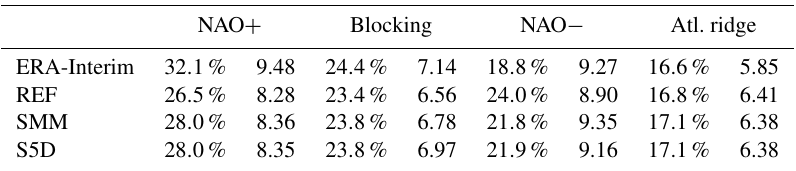
Table 3. Correlation between ensemble mean DJF North Atlantic– Europe weather regime frequencies in experiments REF, SMM, and S5D and ERA-Interim. Weather regimes are defined for a duration of 3 days or more. NAO + Blocking NAO − Atl. ridge REF 0 . 21 − 0 . 03 0 . 25 − 0 .